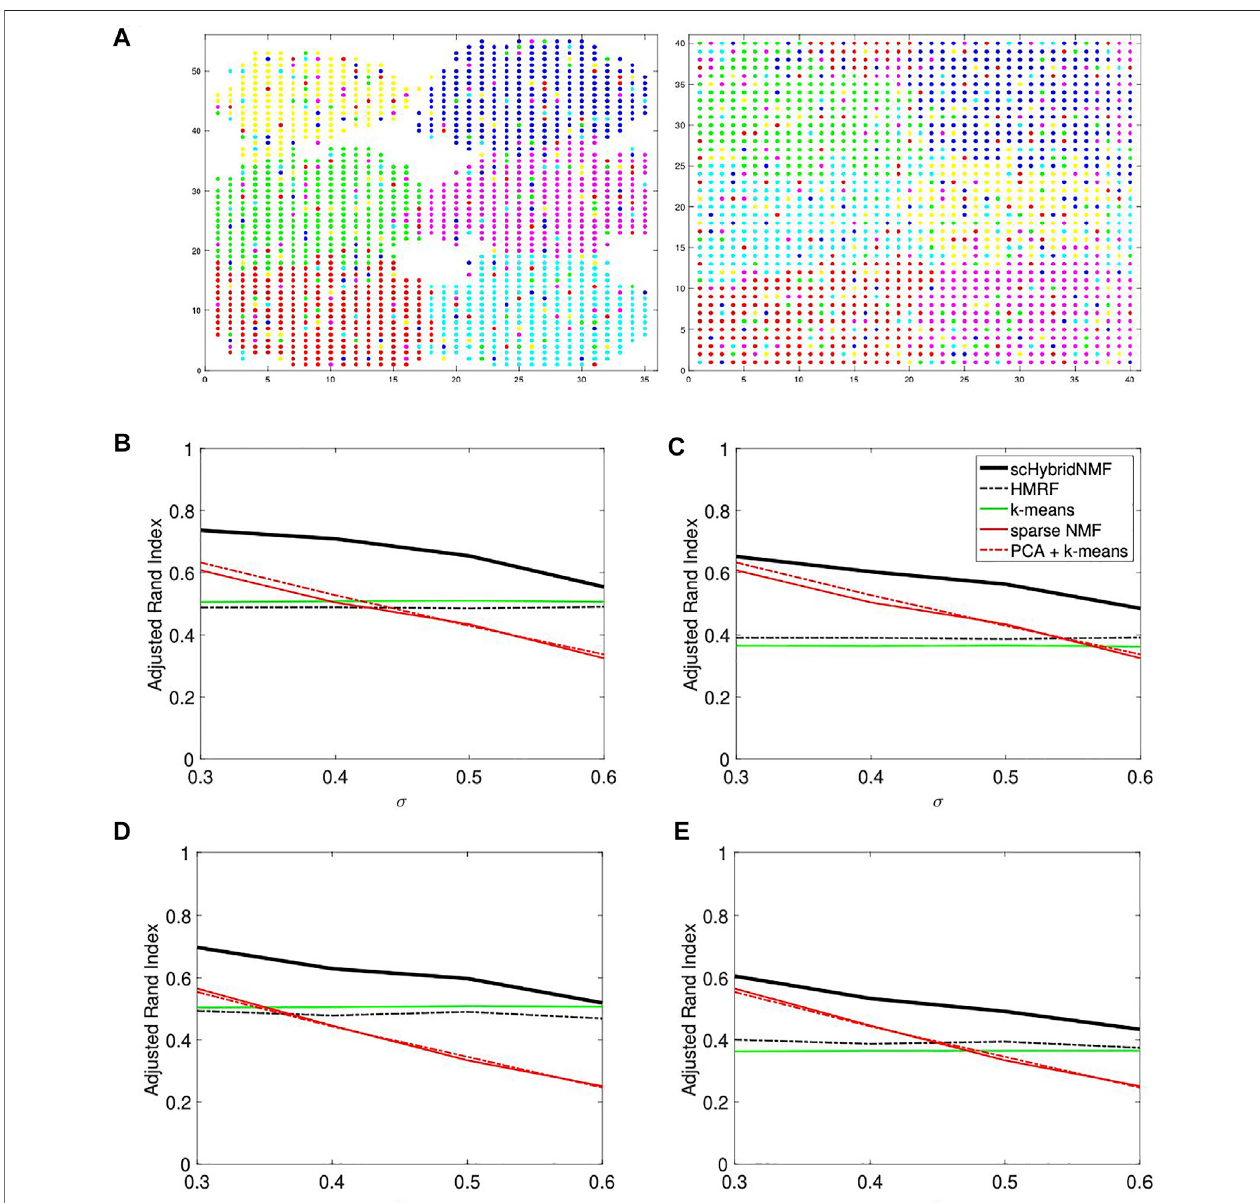
FIGURE 1 | (A) An example of noise in location data. The data had σ (cid:2) 0.3 and 20% noise. In each plot, there are six point colors that correspond to true cluster labels. Left: strong spatial patterns; right: weak spatial patterns. Note that certain cell types are not contiguous in the right plot. (B – E) Performance vs sigma plots for location data with strong spatial patterns. Each plot shares the same legend as plot (C) . (B) No sampling, 20 % noise. (C) No sampling, 30 % noise. (D) 50 % sampling, 20 % noise. (E) 50 % sampling, 30 % noise.